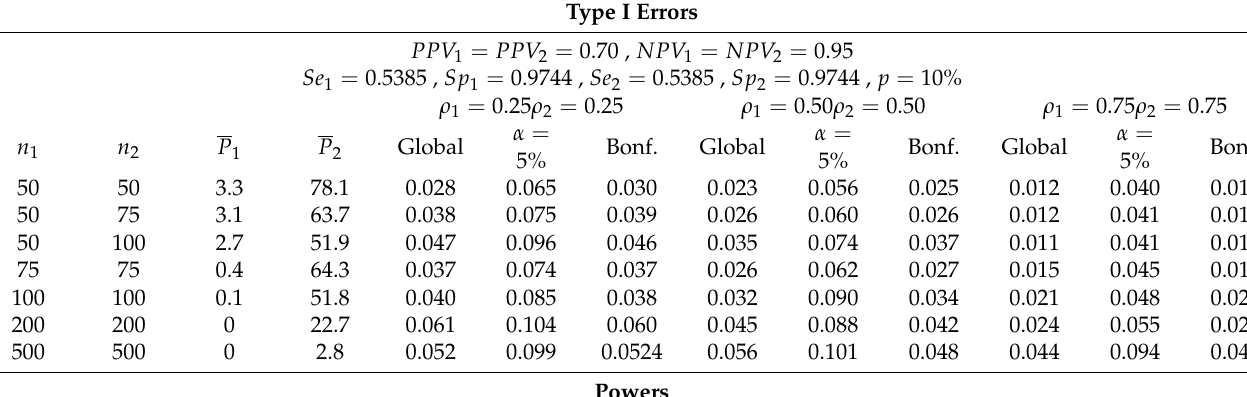
Table 10. Type I errors and powers when 0.5 is added to the samples in which n i 10 = n i 01 = 0. Type I